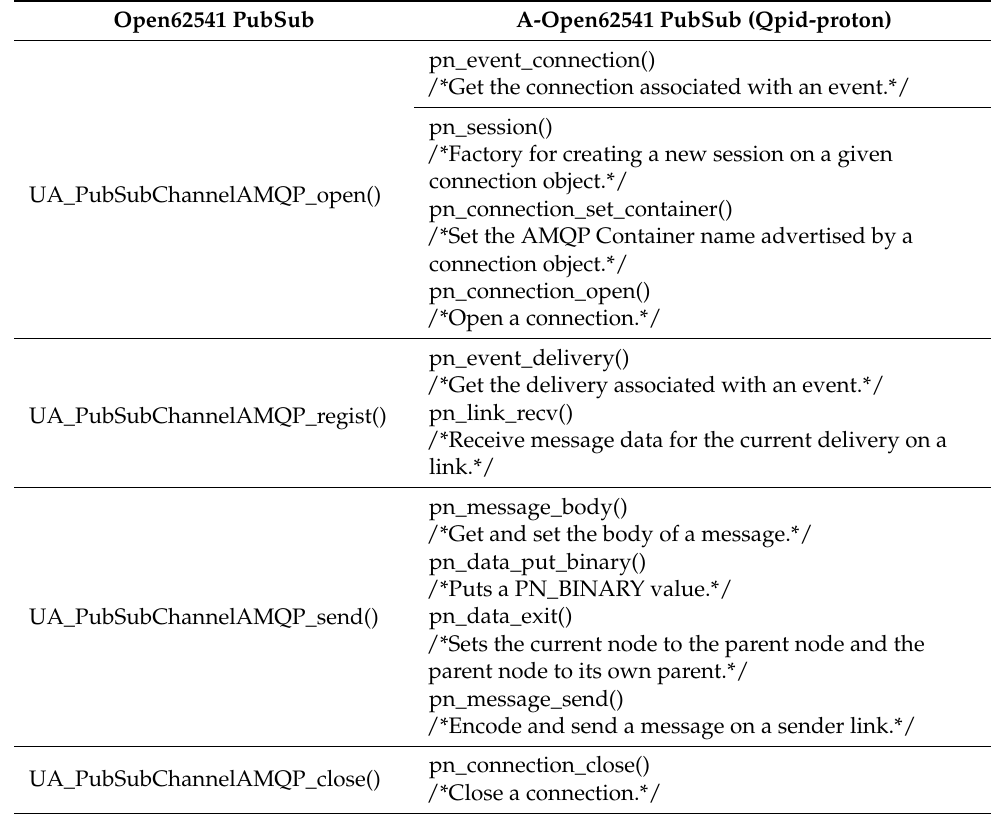
Table 6. A-Open62541 PubSub Qpid-proton